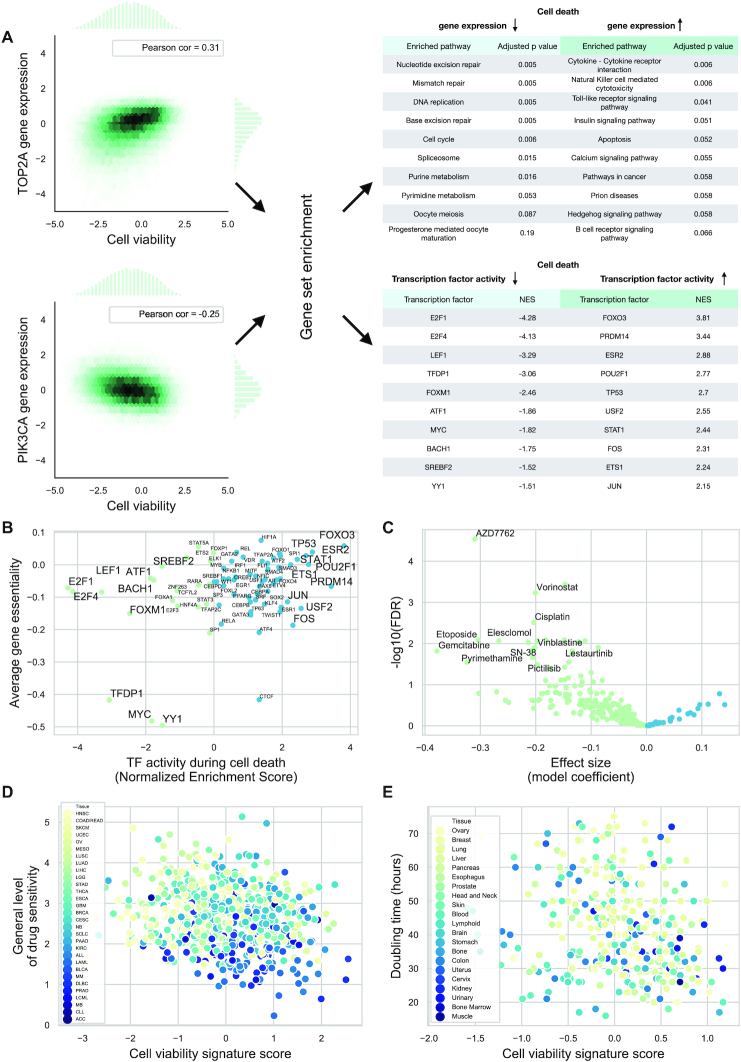
Functional genomics analysis of cell death signature. (A) Pearson correlations between gene expression and cell viability values were calculated for the Achilles-L1000-96h dataset for each gene (left, representative examples for PIK3CA and TOP2A). Using these correlation values, KEGG pathway (top right) and Transcription Factor regulon (bottom right) enrichment scores were calculated. (B) Association between activity and average Gene Essentiality for transcription factors. Negative Gene Essentiality means the genes are essential (Pearson, r: 0.32, P = 0.005). (C) Volcano plot of cell death signature–drug sensitivity associations from the GDSC dataset. Cell death signature scores were calculated for each cell line using baseline gene expression. A linear model was fit to ln IC50s and signature scores (using tissue type and microsatellite instability as covariates) for each drug. FDR corrected P values (y axis) for the coefficient of signature scores are plotted against effect size (linear model coefficient) for the signature score parameters. Negative effect size means IC50 values for a given drug are lower (i.e. increased sensitivity) for cell lines with higher cell viability signature scores. (D) Associations between cell viability signature score and general level of drug sensitivity (GLDS). GLDS was calculated from GDSC drug sensitivity data. Each point represents a cell line (color coded by tissue type). Pearson correlation: r = −0.18 P = 5.02e-07. (E) Association between cell viability signature score and doubling time. Doubling time (and gene expression for signature score calculation) are from the gCSI dataset. Each point represents a cell line (color coded by tissue type)–Pearson correlation r = −0.23, P = 2.4e-5.